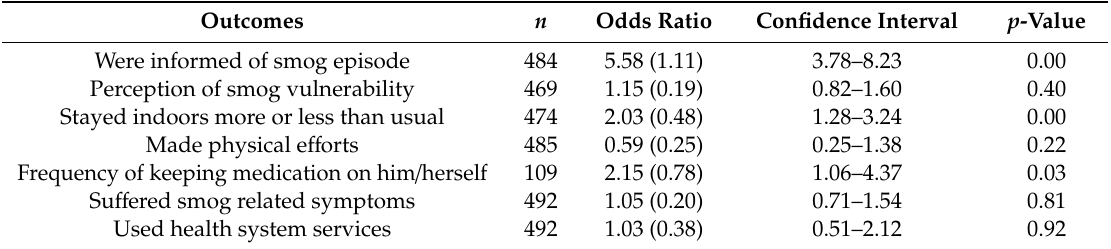
Table 4. Di ff erences between treatment and control groups after exposure to the APWS smog warning.